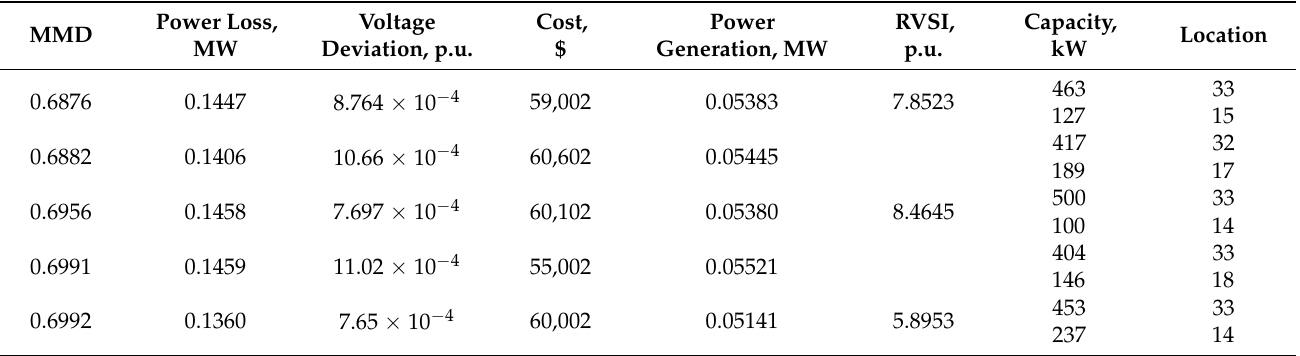
Table 9. Best five neighboring solutions obtained by the Manhattan distance method (two BESSs